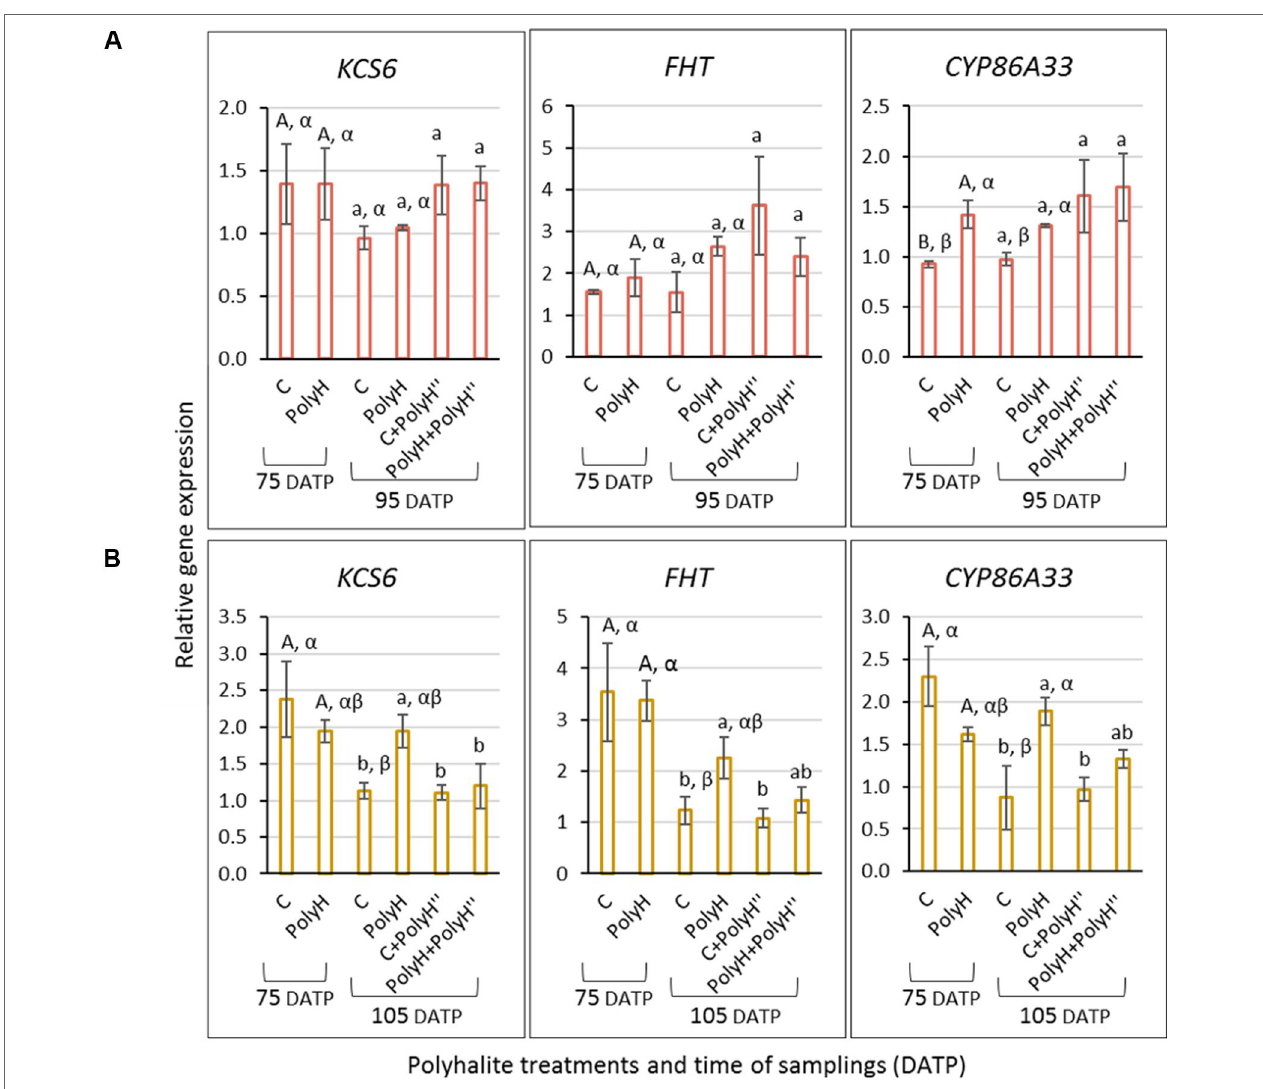
FIgURE 8 | Expression of KCS6 , FHT , and CYP86A33 indicator genes for skin suberization in the peel of tubers from Rosanna (a) and Vivaldi (B) plants (experiment 3). Sample labeling and treatments are as described in Figures 5 and 6 . Peel samples were collected from early-bulking tubers at 75 DATP, and 10 days after the late polyhalite application—95 DATP for Rosanna and 105 DATP for Vivaldi. Gene expression level and statistical analyses were performed as described in Figure 3 . Uppercase letters compare samples from 75 DATP; lowercase letters compare samples from 95 DATP for Rosanna and 105 DATP for Vivaldi; Greek letters compare C and PolyH samples at the two time